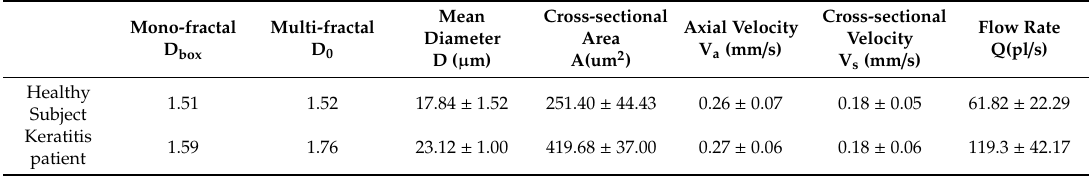
Table 1. Comparison of the quantitative vessel parameters of the healthy and keratitis